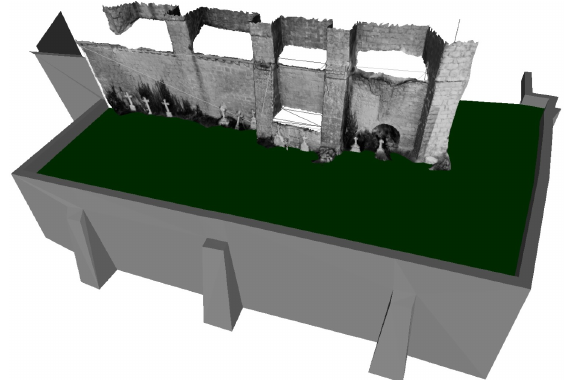
Figure 10. Model of surfaces with photographic textures of the graveyard, complemented with meshes obtained from the old wireframe model. Figure 12. 3D modeling from perspective. On the left it is shown the photograph with the identification of the vanishing directions, on the right, a view of the 3D model with